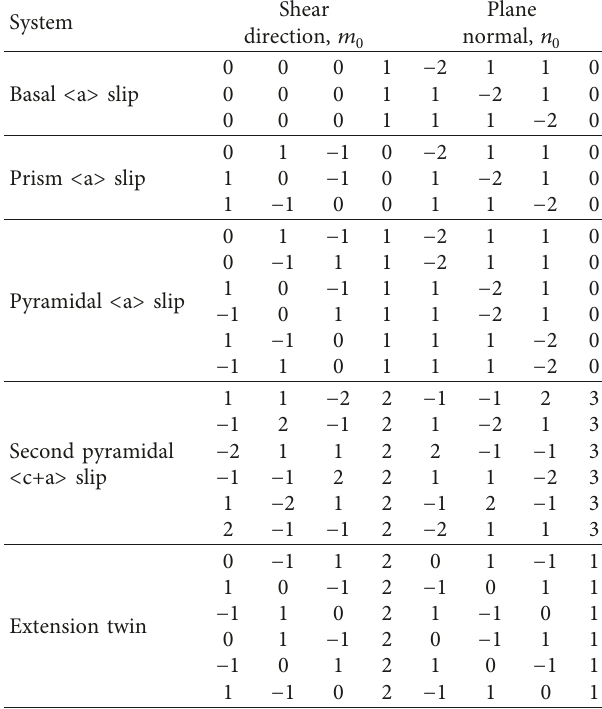
Table 1: Various slip and twin systems used in the crystal plasticity simulations for